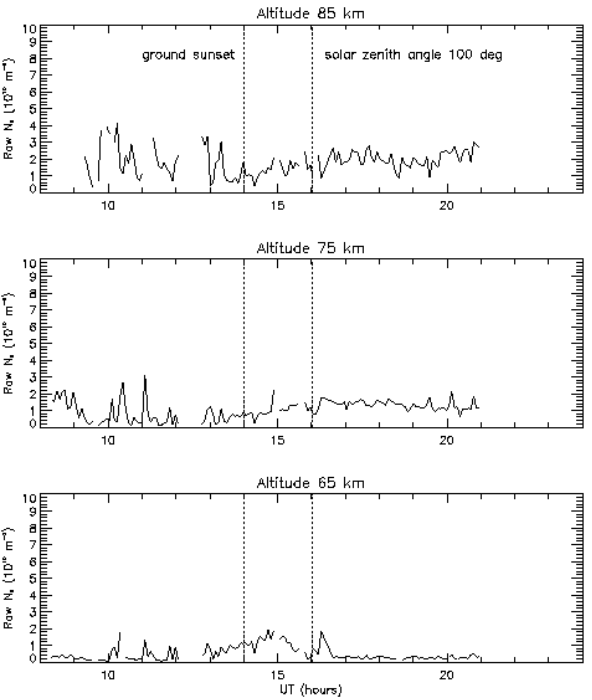
Fig. 4. Electron densities determined by the EISCAT VHF radar at Troms¨o on 28 October. The radar operated from 08:15 to 24:00 UT.